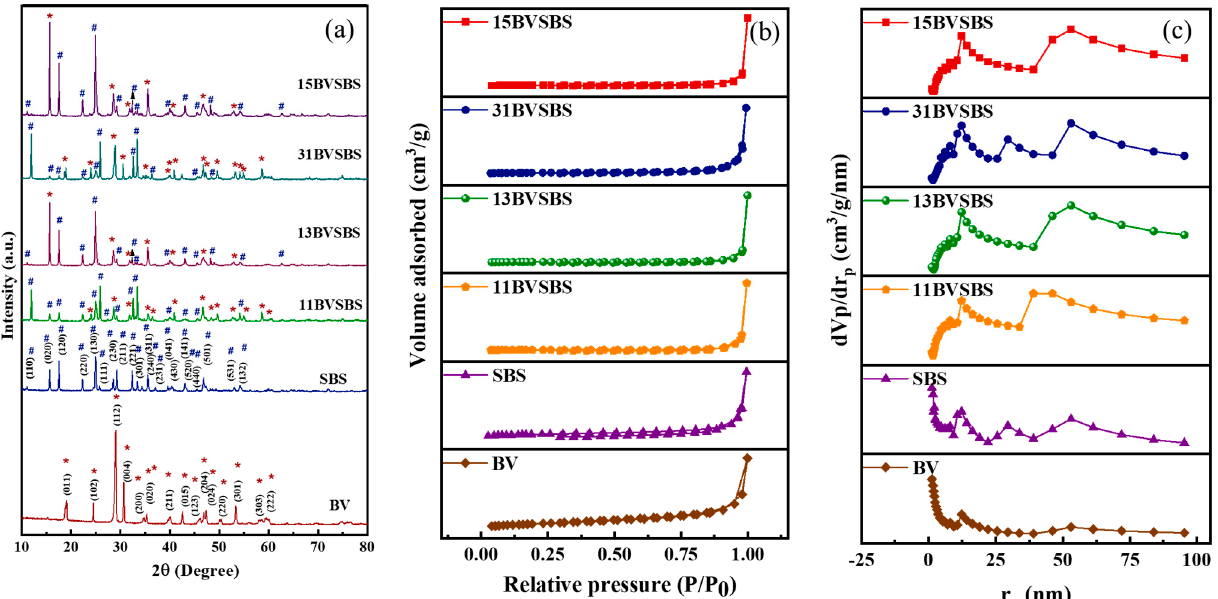
Figure 2. ( a ) XRD plot of the fabricated photocatalysts where * and # denote peaks of BV, and SBS, respectively, ( b ) BET surface area isotherm, and ( c ) BJH graph.